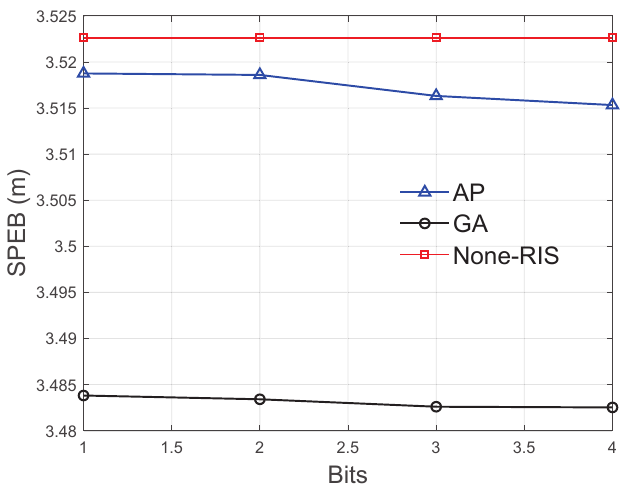
Figure 3. SPEB with different bit numbers of